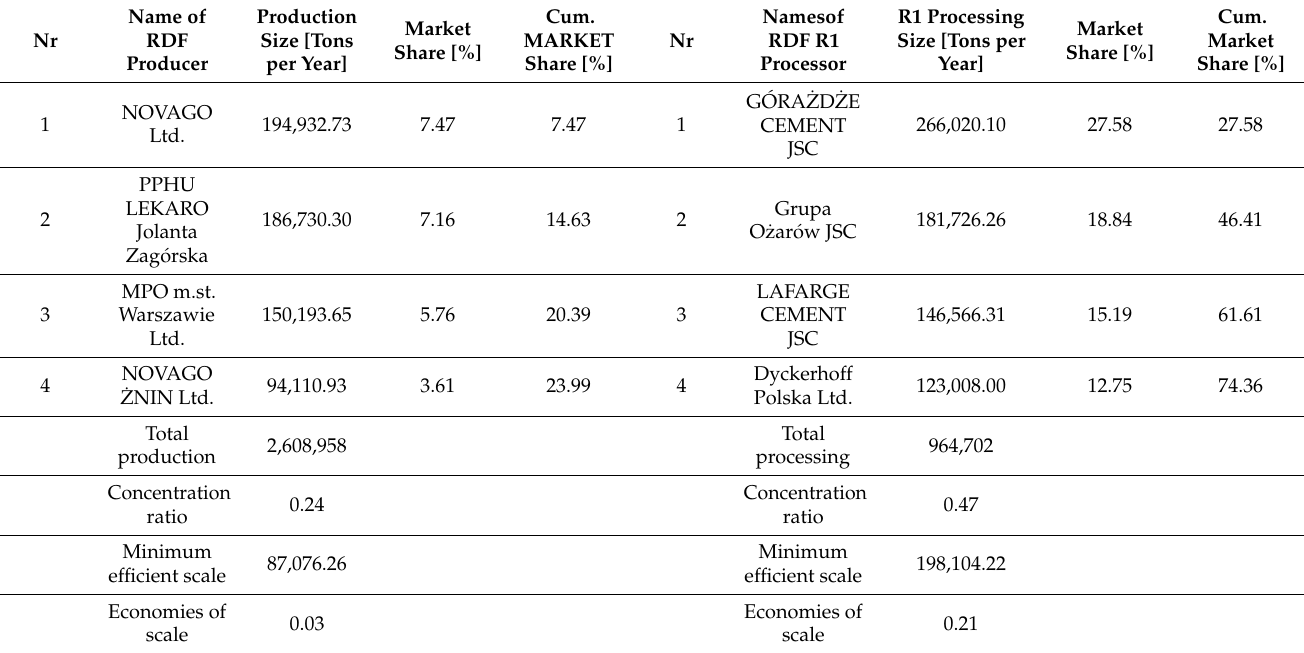
Table 4. Structural analysis of WTE (RDF producers and processors) in Poland in